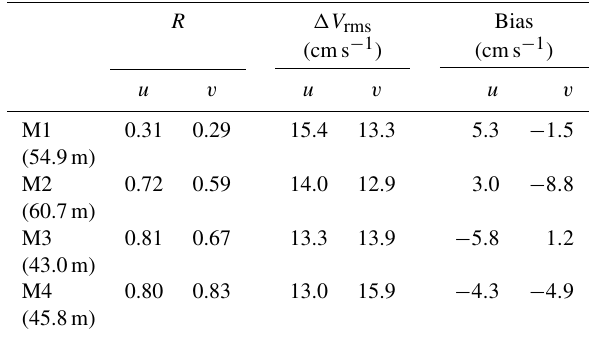
Table 2. Summary of comparison statistics for satellite altimetry and moored current meter, with R (the correlation coefficient), (cid:49)V rms (the root mean square differences between the zonal and meridional components of ADCPs and those from altimetry (Eq. 1)) and the bias between those components (Eq.